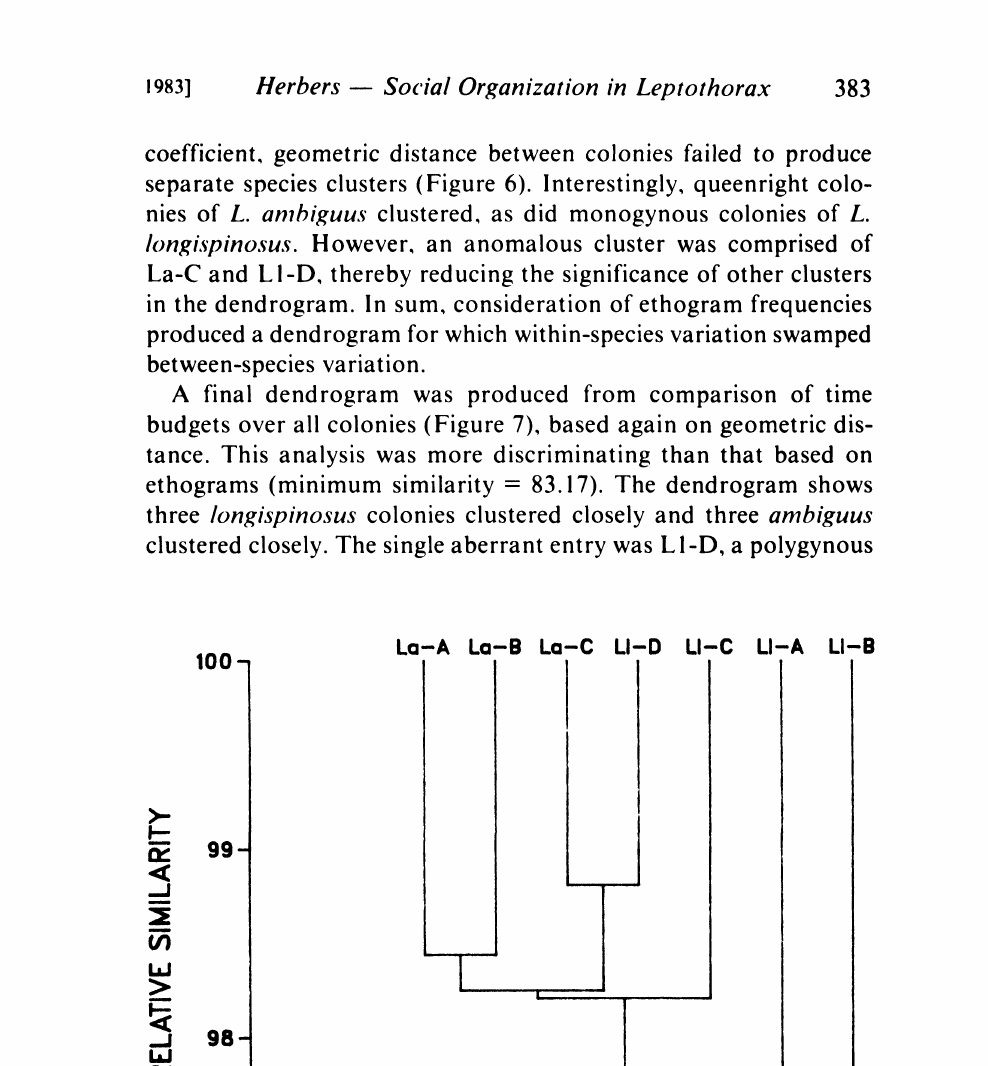
Figure 6. Dendrogram of similarity derived from geometric distance based on ethogram